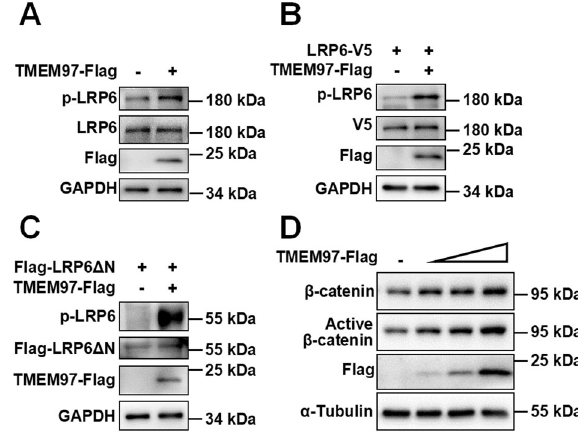
Fig. 3 TMEM97 increases LRP6 phosphorylation at Ser1490 and enhances the protein level of β -catenin. A TMEM97